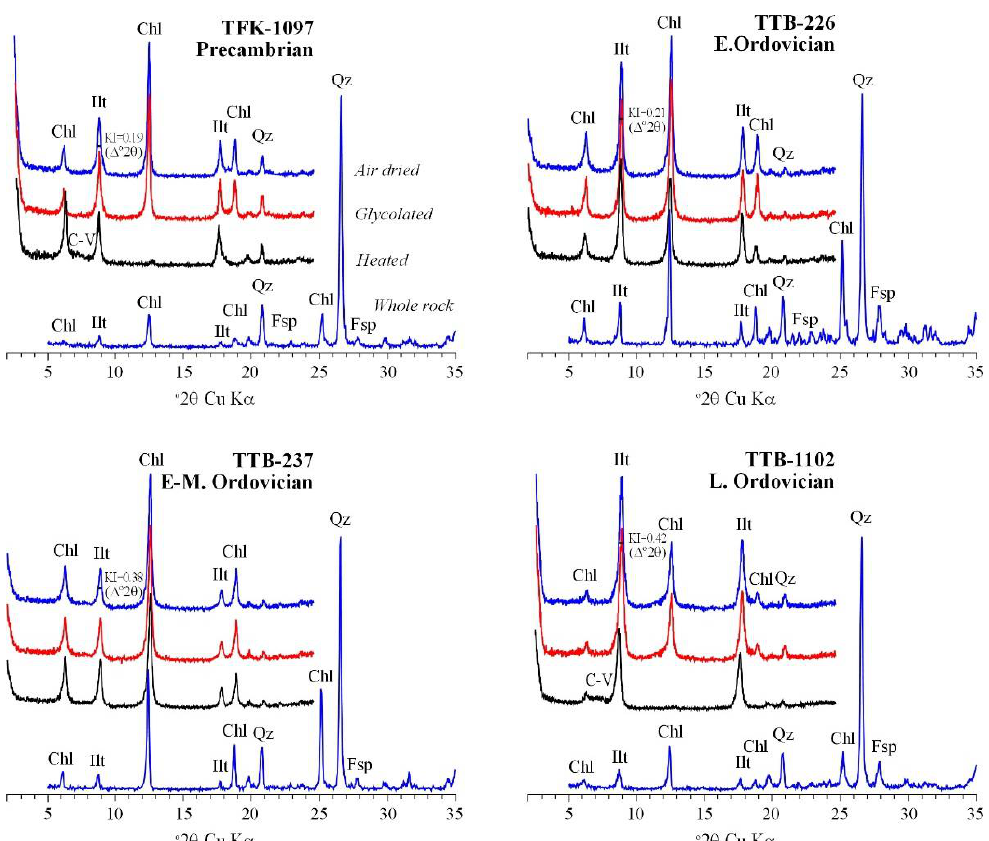
Figure 9. XRD patterns of whole rock and clay fraction of Precambrian–Ordovician metaclastic rocks. Chl = Chlorite, Fsp = Feldspar, Ilt = Illite, Ms = Muscovite, Qz = Quartz, C-V = Mixed-layer chlorite–vermiculite, KI = Illite Kübler index. Table 2. Bulk and clay/phyllosilicate mineral composition and crystal–chemical data of illites of studied samples.